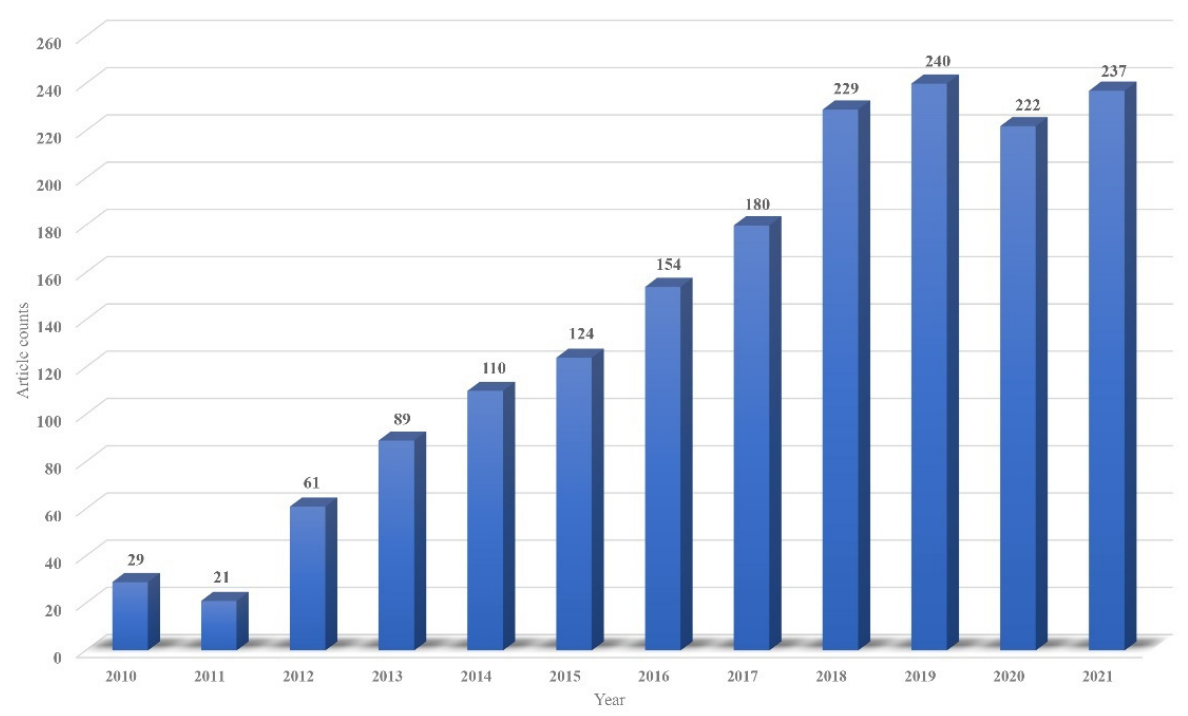
Figure 1. The bar chart shows the number of papers published each year from 2010 to 2021. These data are from the Web of Science, and the retrieved content is “paper-based microfluidic device (Topic)”.